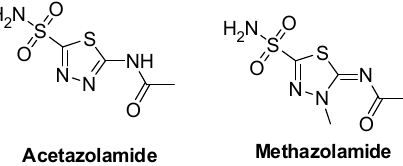
Figure 1. Examples of medications containing 1,3,4-thiadiazole ring.